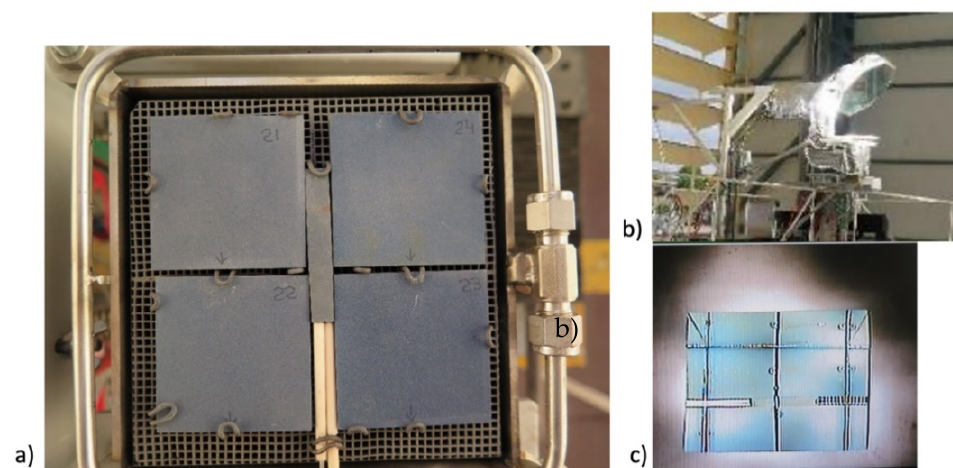
Figure 1. Schematic diagram of the solar ageing test bench in a horizontal solar furnace facility.